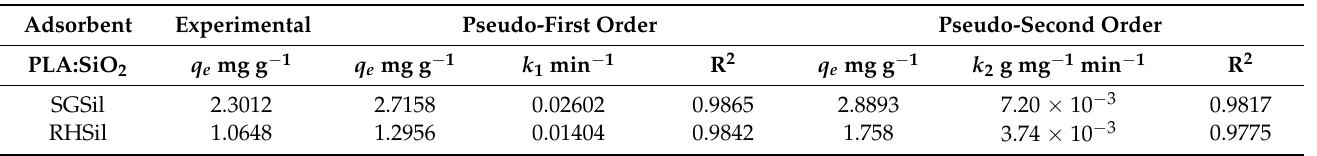
Table 2. Kinetic parameters of RhB dye adsorption from pseudo-first-order and pseudo-second-order models.